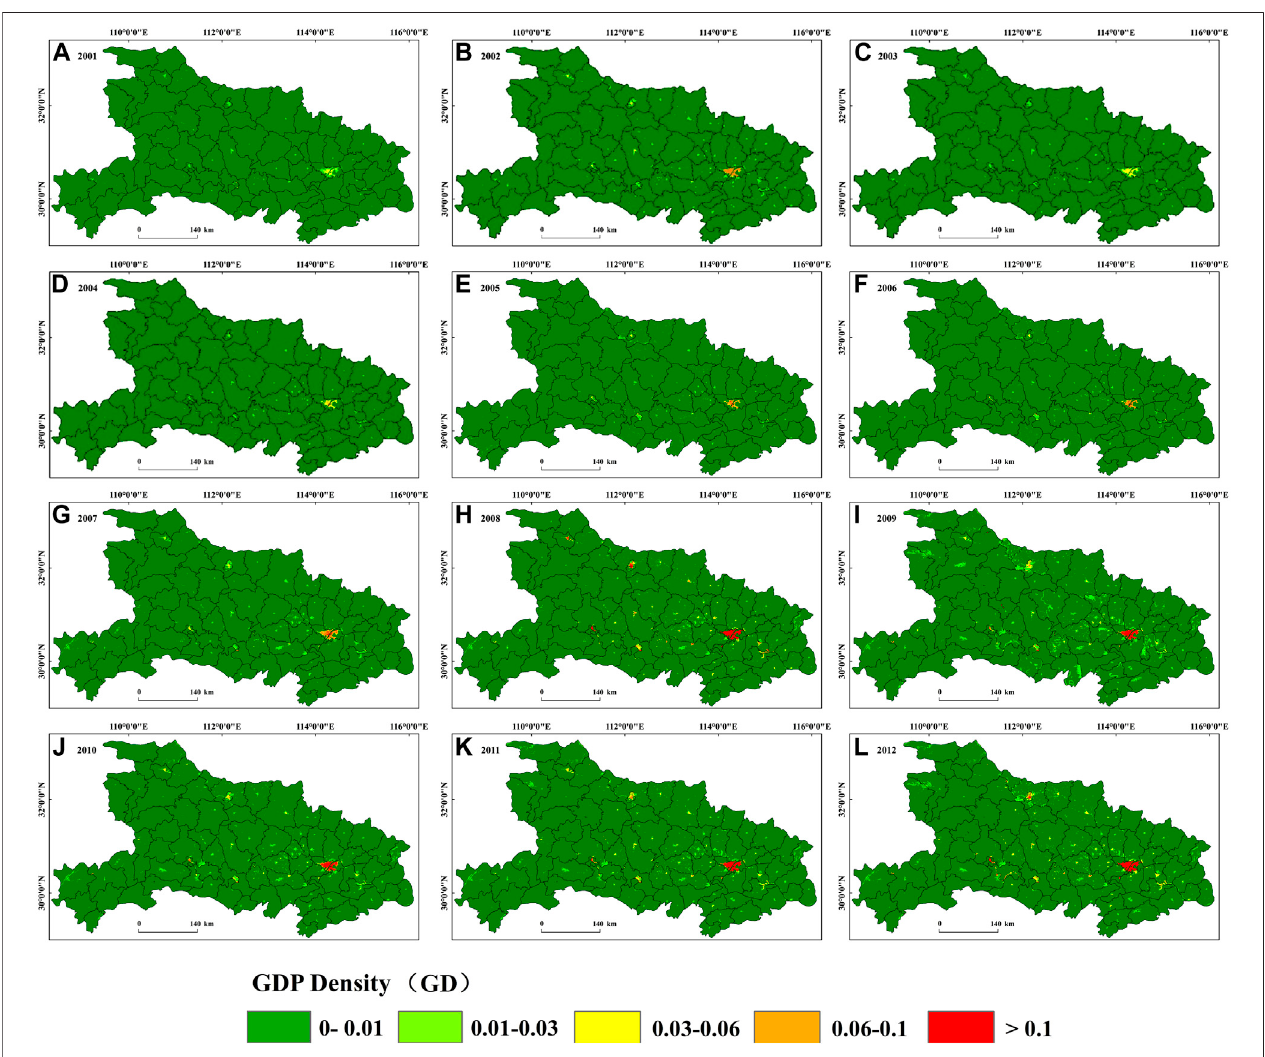
FIGURE 10 | GDP density maps with a 250 m × 250 m grid. (A) – (L) the different maps from 2001 to 2012.